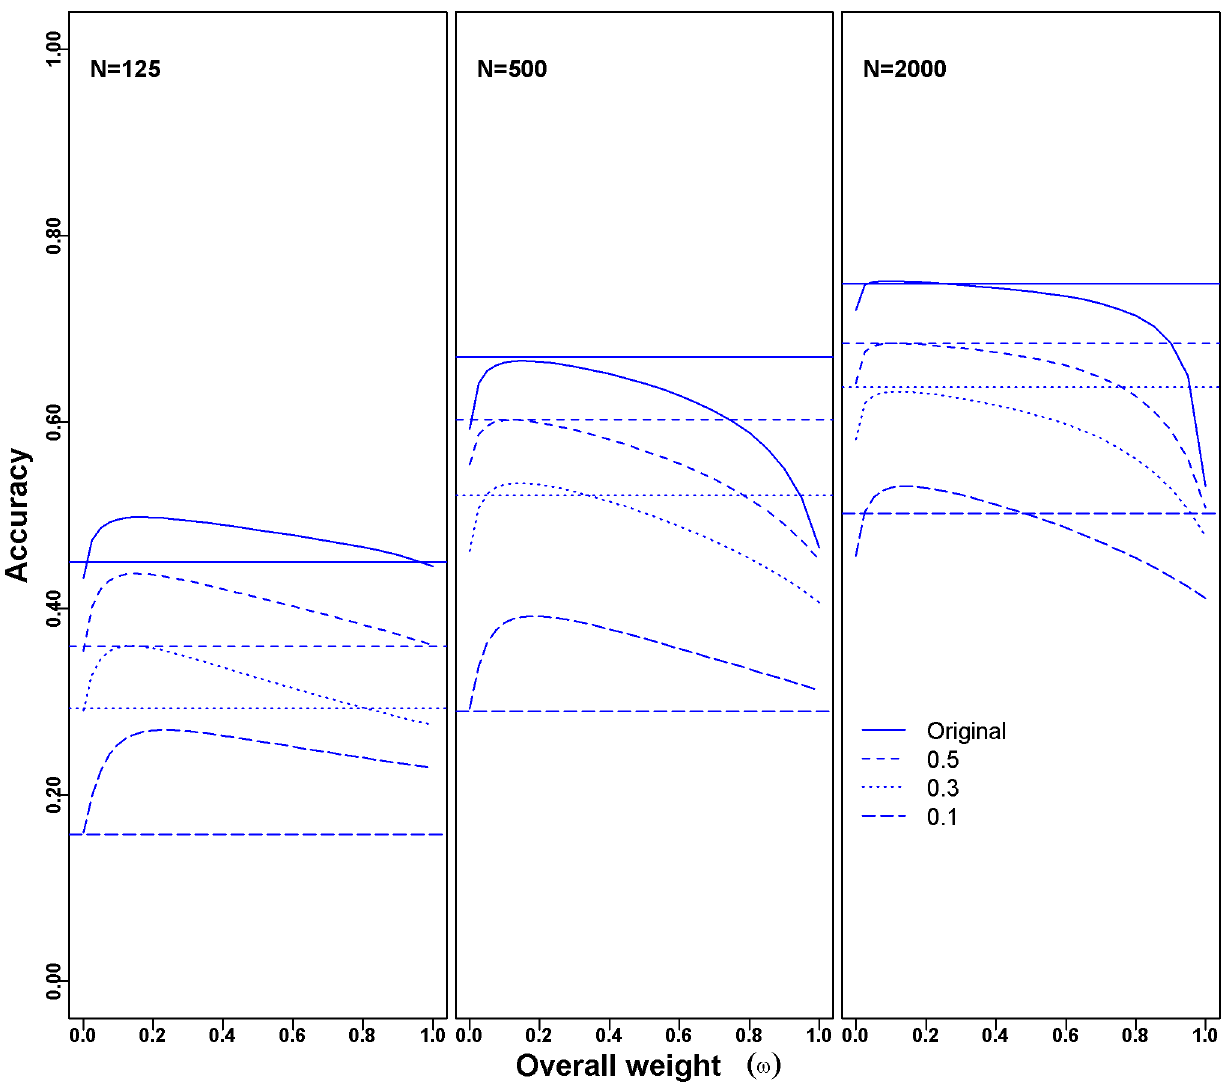
Figure 2. Accuracy of WGP for simulated traits with different heritabilities and sample sizes. The curves show the change of the accuracy obtained with BLUP|GA for varying overall weight v for milk yield. Different curves represent the accuracies obtained from traits with original phenotype (solid line), or simulated phenotypes with heritability of 0.5 (short-dashed line), 0.3 (point line) and 0.1 (long-dashed line), respectively. The numbers of QTL counts were used to infer the marker weights for the BLUP|GA approach. The GBLUP approach corresponds to scenarios in which v =0 (starting points for each curve), and the accuracies of BayesB are presented by horizontal lines. Accuracies were calculated as the mean of 20 replicates of five-fold cross-validation with different population sizes (N= 125, 500, and 2000).